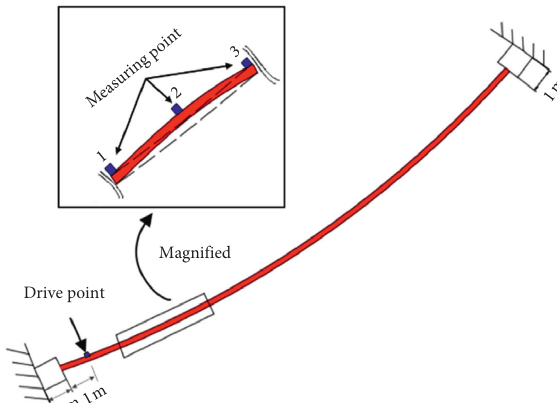
Figure 10: Cable